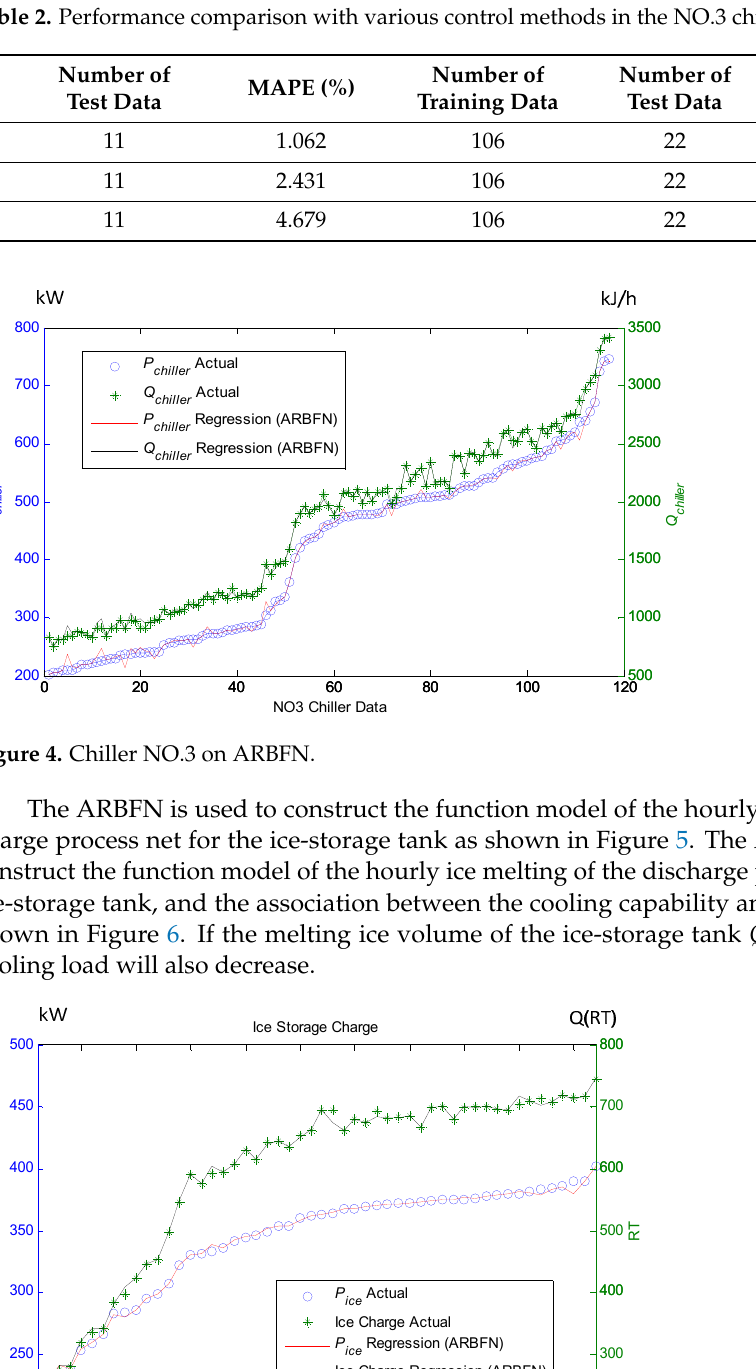
Figure 5. Charge process net.